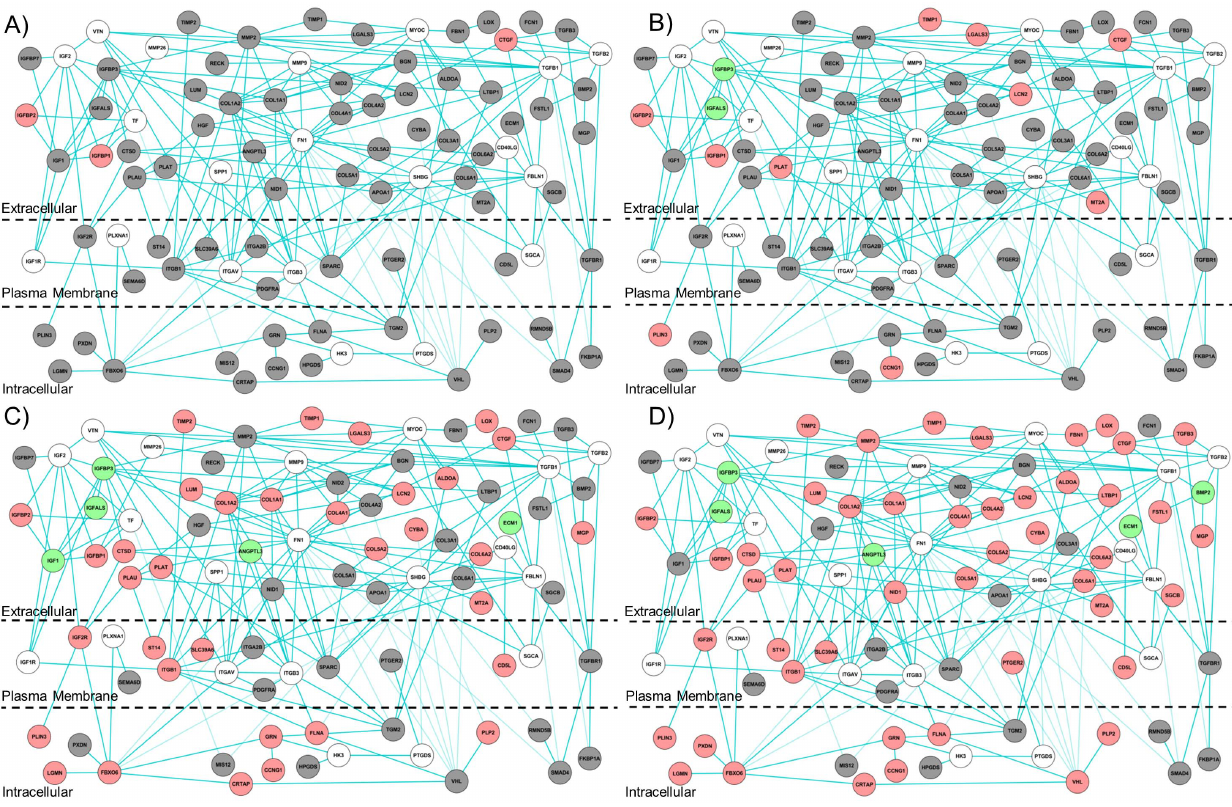
Figure 7. Activation of genes encoding proteins in liver fibrosis-relevant network module M5 at different time points. Genes encoding proteins with average log 2 fold-change ratios . 0.6 are colored in red. Genes encoding proteins with average log 2 fold-change ratios ,2 0.6 are colored in green. Genes encoding proteins with average log 2 fold-change ratios between 0.6 and 2 0.6 are colored in grey. A) Activation at 0.25-day exposure. The mapped expression profile is the average log 2 ratio in 1-naphthyl isothiocyanate 30 mg/kg and 60 mg/kg, at 0.25-day exposure. B) Activation at 1 day of exposure. The mapped expression profile is the average log 2 ratio in 1-naphthyl isothiocyanate 30 mg/kg and 60 mg/kg, and 4,4’-Methylenedianiline 81 mg/kg, at 1 day of exposure. C) Activation at 3 days of exposure. The mapped expression profile is the average log 2 ratio in 1-naphthyl isothiocyanate 30 mg/kg and 60 mg/kg, and 4,4’-Methylenedianiline 81 mg/kg, at 3 days of exposure. D) Activation at . 3 days of exposure. The mapped expression profile is the average log 2 ratio across chemical exposures that produced liver fibrosis.